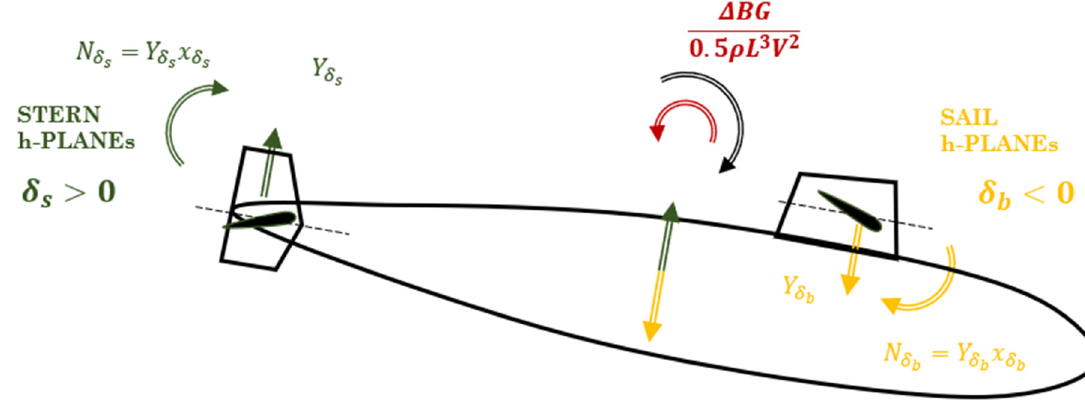
Figure A1. Meander test forces.